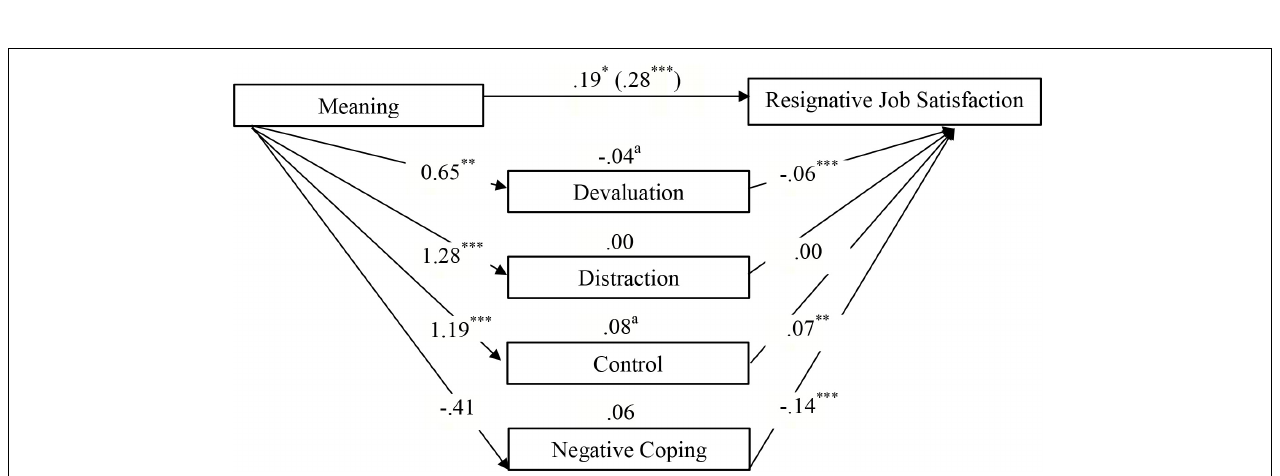
FIGURE 3 | Direct, indirect, and total effects (in brackets) of Engagement on content-related Job Satisfaction via the mediators Positive (Devaluation, Distraction, Control) and Negative Coping Strategies. It was controlled for age and gender. ∗∗ p < 0.01. ∗∗∗ p < 0.001. a Significant point estimates ( p < 0.05).